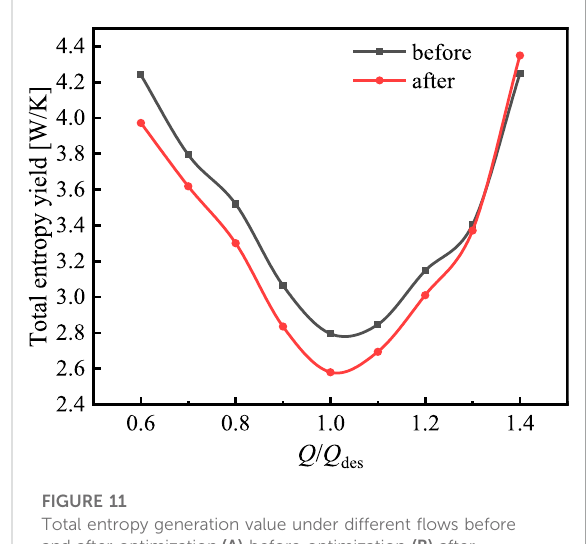
FIGURE 11 Total entropy generation value under different fl ows before and after optimization. (A) before optimization (B) after optimization.